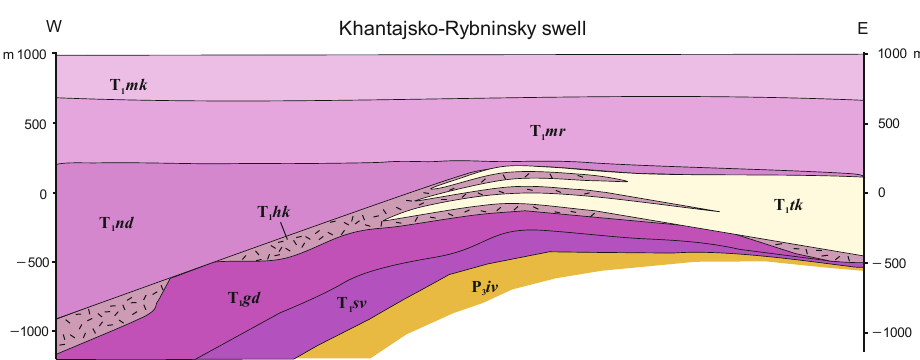
Figure 22. Reconstruction of tuff–lavas structure in the Norilsk area for Early Triassic time.